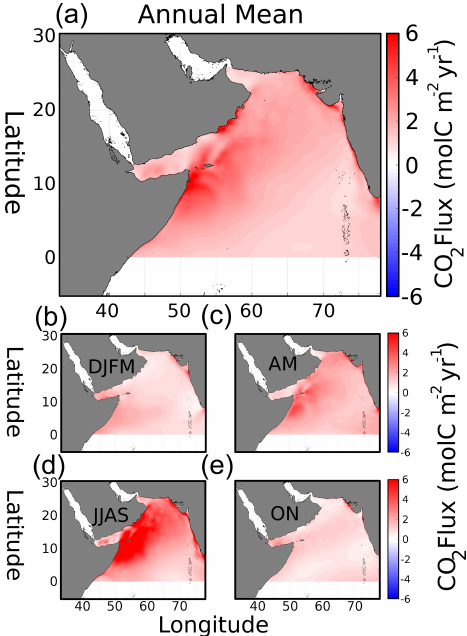
Figure 6. (a) Modeled annual mean air–sea CO 2 flux density (molCm − 2 yr − 1 ). (b–e) Seasonal flux density for winter (DJFM), spring (AM), summer (JJAS), and fall (ON), respectively. Positive is flux out of the